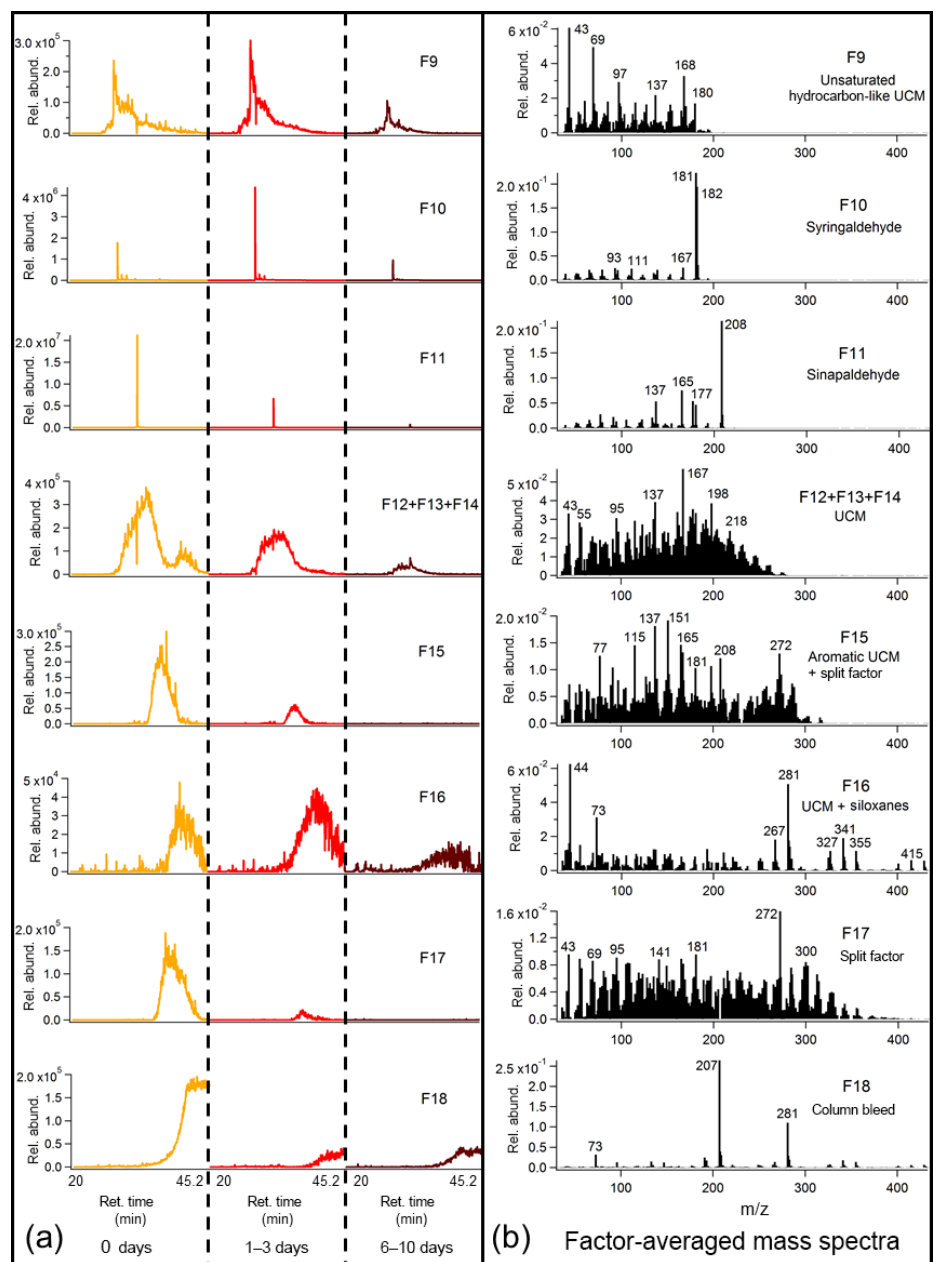
Figure 5. Average binned chromatograms and mass spectra for factors 1–8 (F1–8) in PMF 18-factor solution on TAG oak heartwood BBOA compound window data. Relevant plots obtained in PMF calculations are provided in the Supplement (Figs. S12b and S13b). These chromatograms were obtained from PMF calculations by averaging binned data corresponding to triplicate chromatograms at each level of oxidation. The triplicate-averaged binned chromatograms at each equivalent aging time are displayed in one trace; different aging times are demarcated with vertical lines across the x axis. Average binned chromatograms and mass spectra for factors 9–18 (F9–18) in PMF 18-factor solution on TAG oak heartwood BBOA compound window data. Relevant plots obtained in PMF calculations are provided in the Supplement (Figs. S12b and